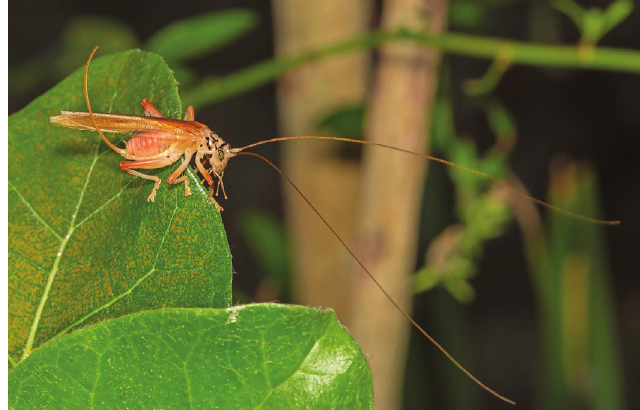
Fig. 4. Stictogryllacris lyrata from the northern face of the Soutpans- berg range in South Africa. Body length about 15 mm.